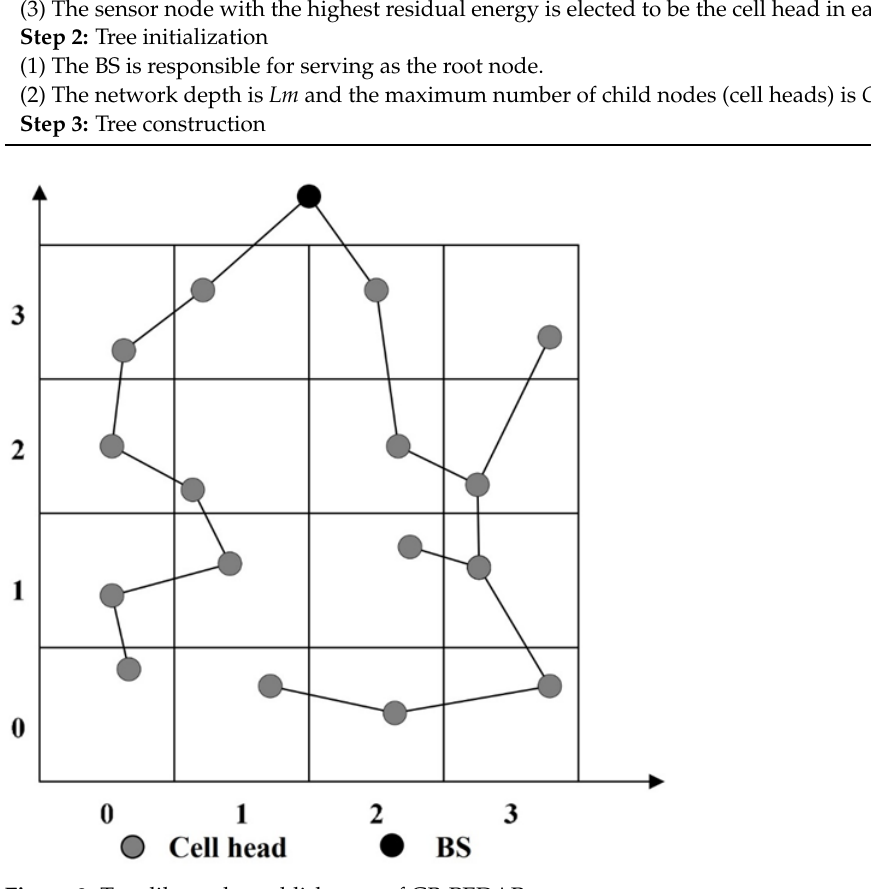
Figure 3. Tree-like path establishment of GB-PEDAP.